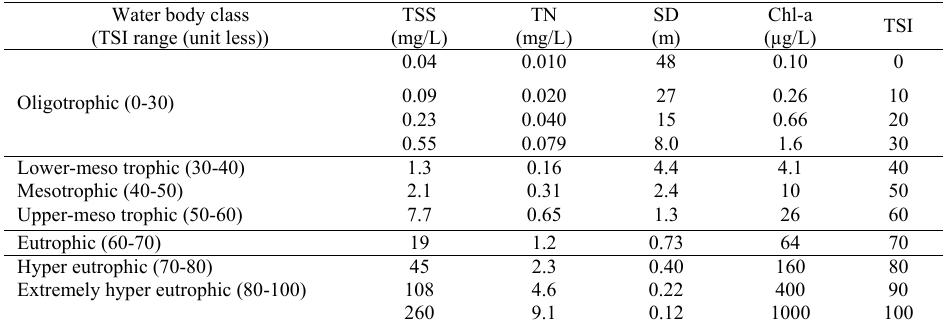
Table 1. Standard (S) eutrophication index TSI for different parameters Water body class (TSI range (unit less))